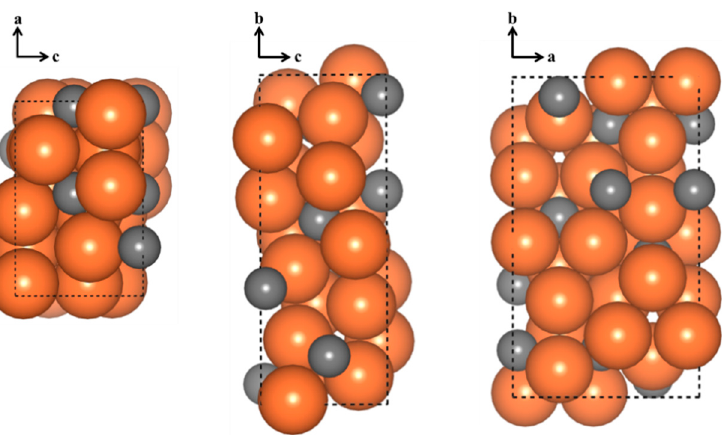
Figure 1. Images of a − c, b − c, and a − b planes of unit cell of o-Fe 7 C 3 . Orange and gray balls in the figure represent Fe and C, respectively.